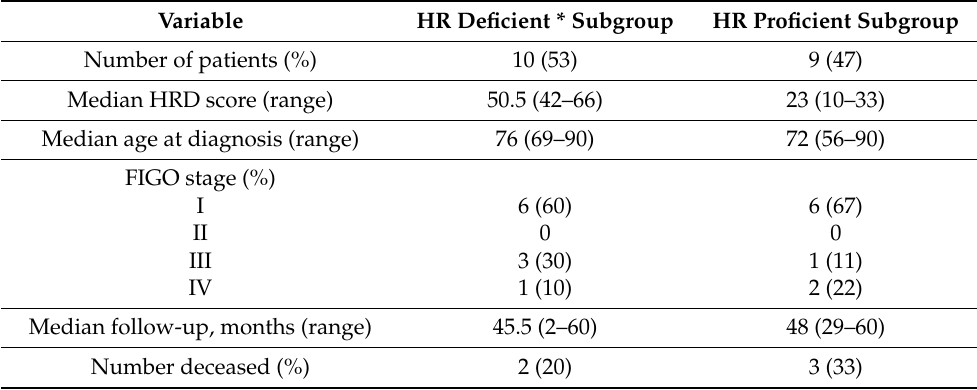
Table 1. Summary of patient-related and clinical